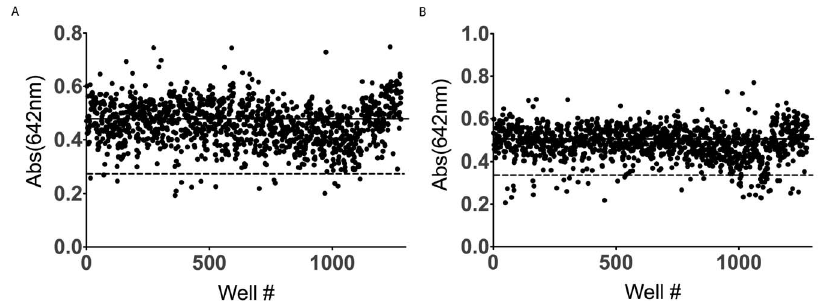
Figure 5. Screen of Spectrum Library. Solid line represents mean negative control. Dashed line represents 3 standard deviations from control and consideration as a hit. (A) In plate one, 16 compounds were identified as initial hits. (B) In plate 2, an additional 43 compounds were identified as initial hits.